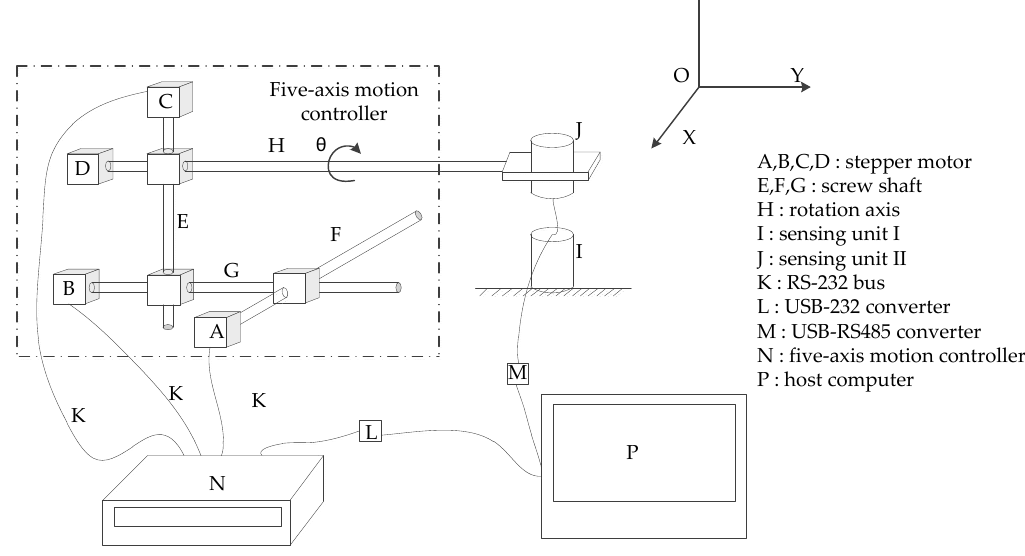
Figure 7. The schematic diagram of data acquisition experimental device.